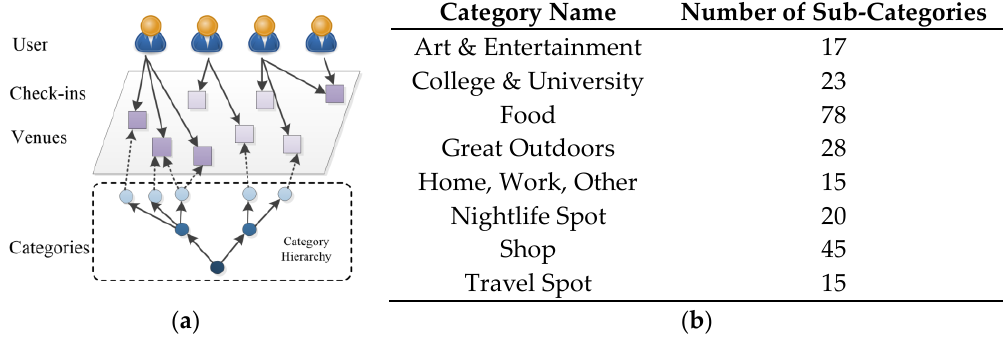
Figure 1. Data Structures in Location-Based Social Networks: ( a ) Overview of a location-based social network (adapted from [27]), ( b ) Detailed location category hierarchy in Foursquare.